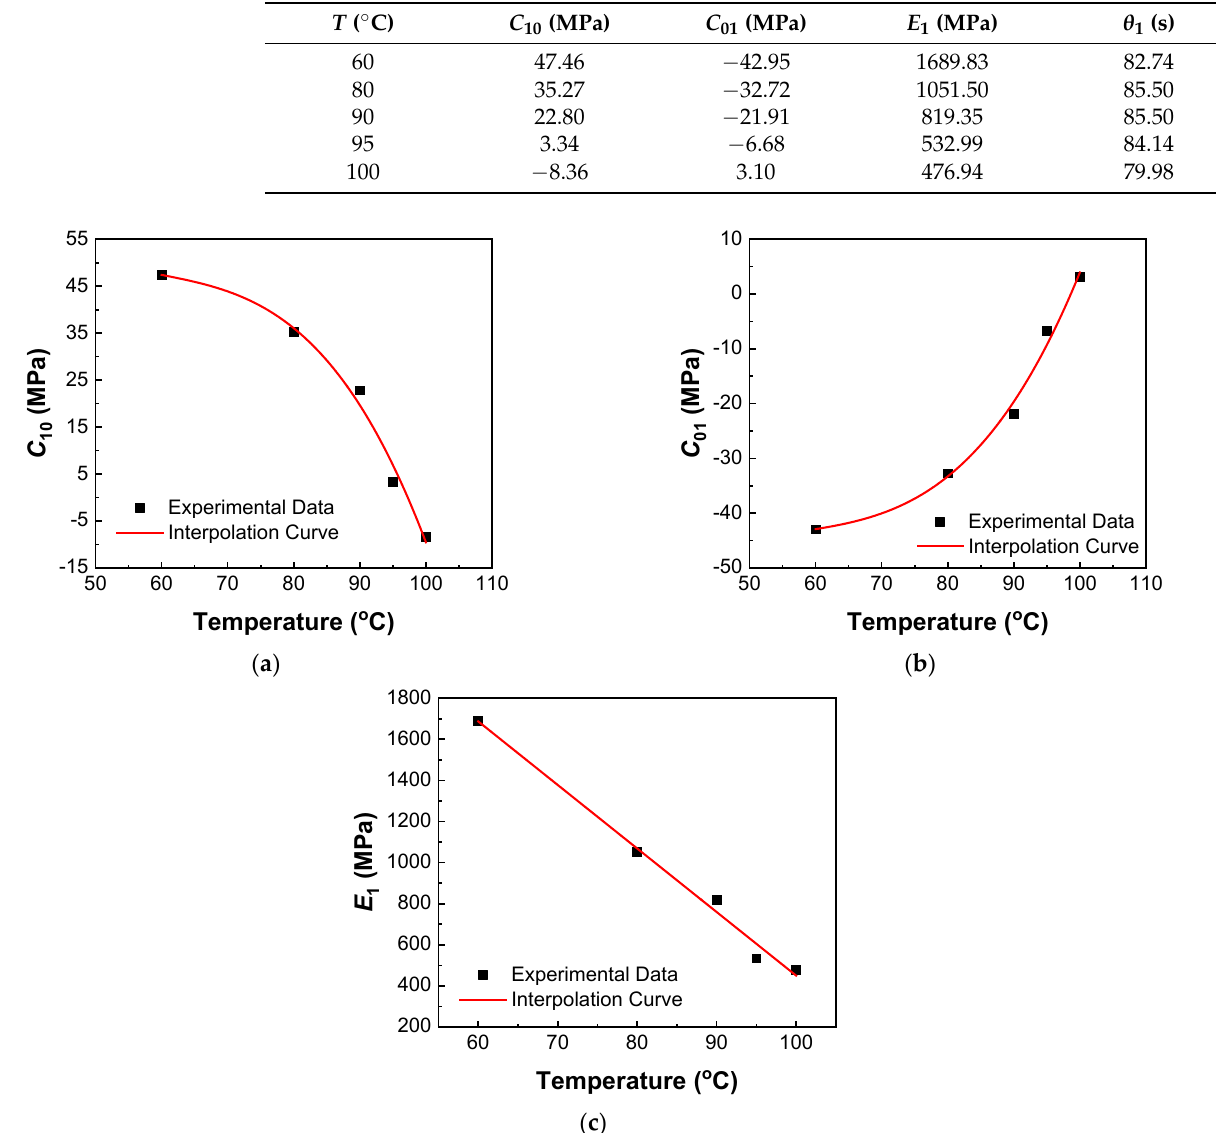
Figure 7. The model parameters’ variations with temperature and the interpolation curves: ( a ) C 10 ; ( b ) C 01 ; ( c ) E 1 . Table 4. Interpolation functions of the parameters in modified ZWT model. Expressions of the Interpolation Functions